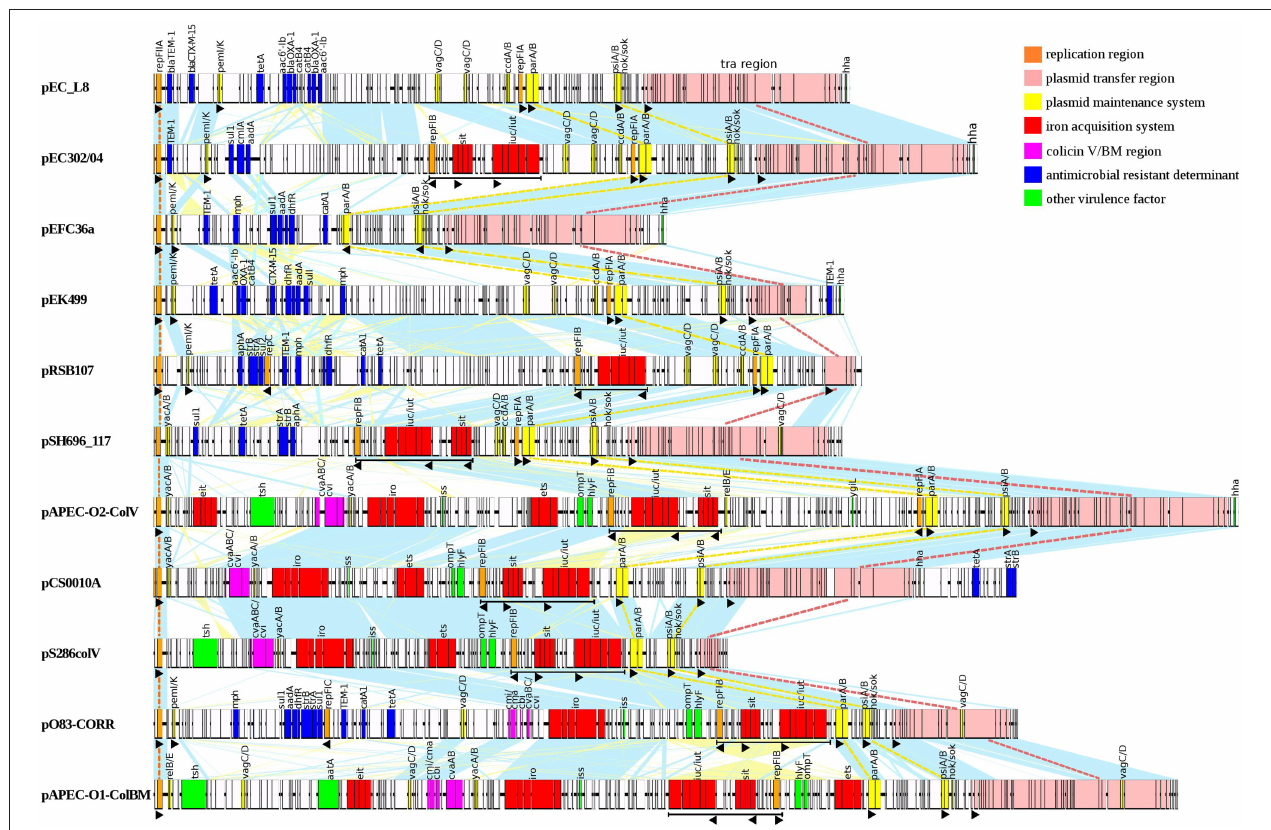
FIGURE 5 | Pairwise nucleotide comparative map of 11 multireplicon IncFIIA plasmids which are closely related to pEC302/04. Same-strand DNA similarity is shaded light blue while reverse similarity is shaded light yellow. Coding sequences are displayed as rectangles. Major features are displayed in colors based on functional annotations: orange, replication; pink, plasmid transfer region; yellow, addictive systems; red, iron acquisition systems; purple, colicin V/BM; blue, antimicrobial resistance; green, other virulence factors; white, other genes. Black triangle depicts the orientation of specific ORF(s).